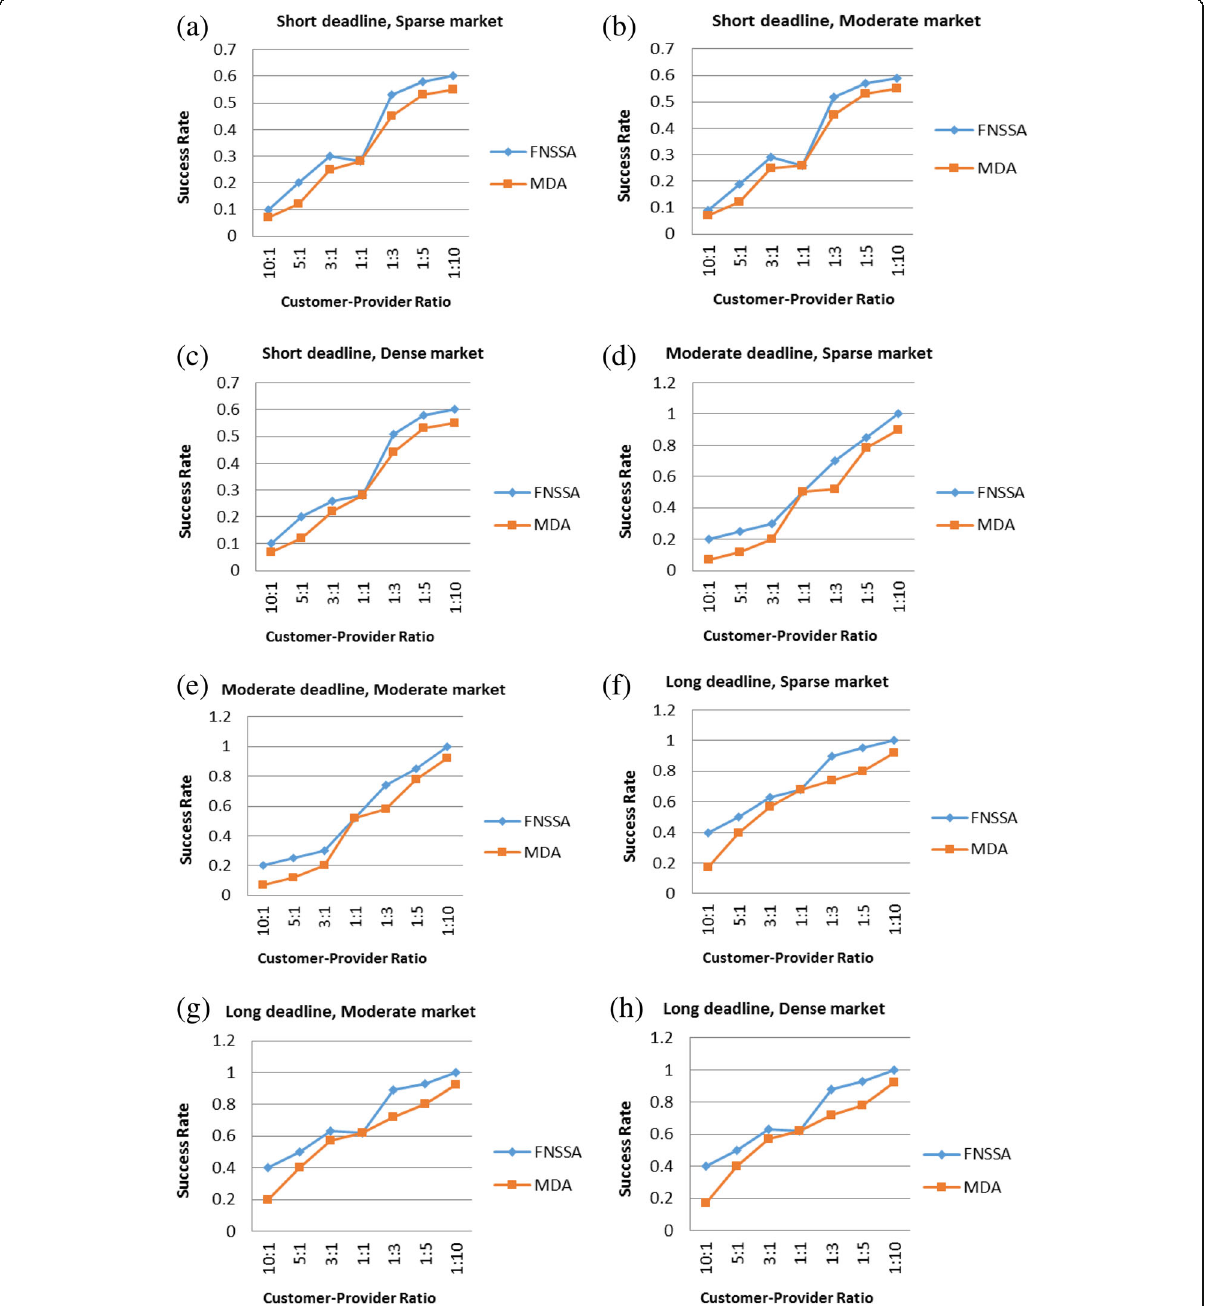
Fig. 6 Success rate of the CRBAs under a short deadline and sparse market, b short deadline and moderate market, c short deadline and dense market, d moderate deadline and sparse market, e moderate deadline and moderate market, f long deadline and sparse market, g long deadline and modearte market, and h long deadline and dense market. In all figures different market types are